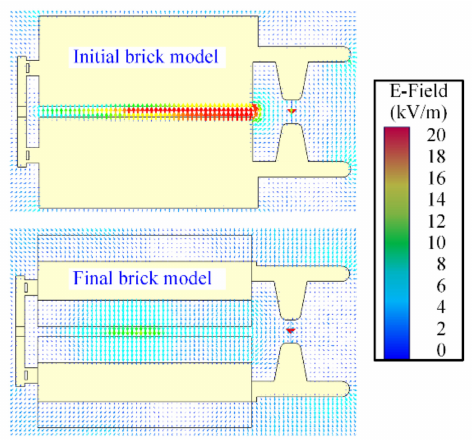
Figure 15. Cross-sectional view of the electric field vector at the instant of maximum brick current.